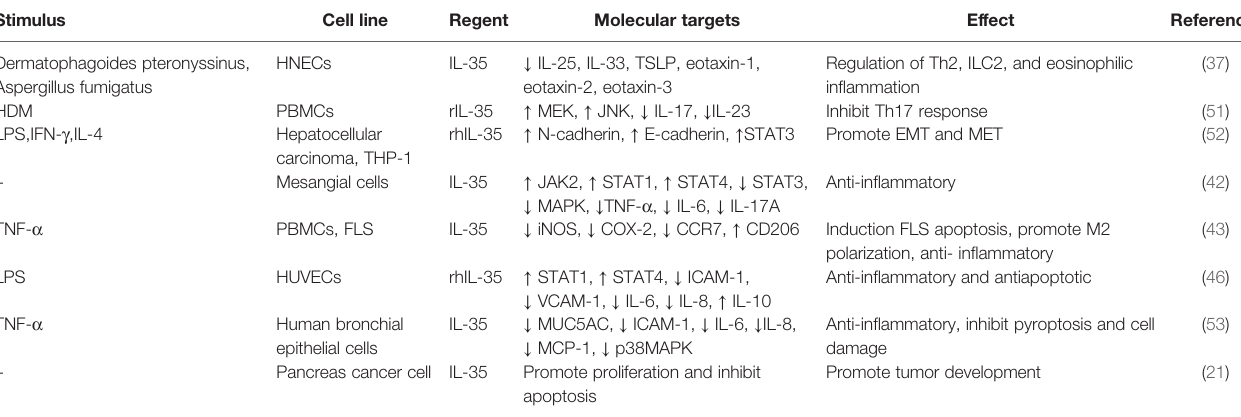
TABLE 2 | Functional study of IL-35 at cellular level in vitro